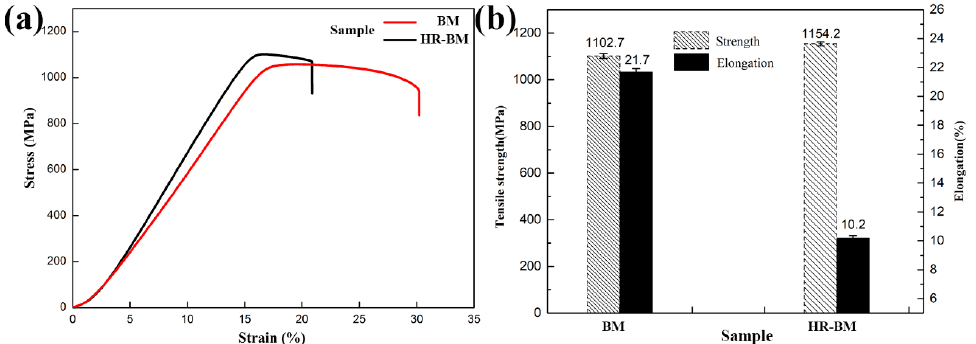
Figure 3. ( a ) Stress–strain curves, and ( b ) tensile strengths and elongations of samples BM and HR- BM.